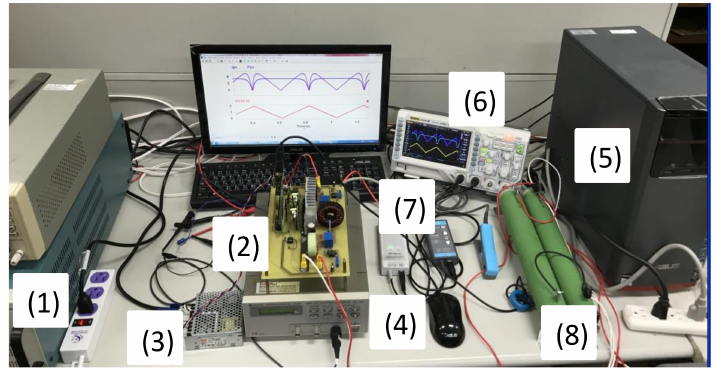
Figure 12. Complete hardware implementation of the proposed PV module emulator. In case 1, theoretical characteristics of the two PV modules under normal irradiance (S = 1000 & 1000) are used. Figure 13a,b shows a set of simulation and measured re- sults from the PV emulator ( I PV : 5 A/div; V o : 40 V/div; T : 2 s/div; V PV : 48 V/div; P PV : 270 W/div).